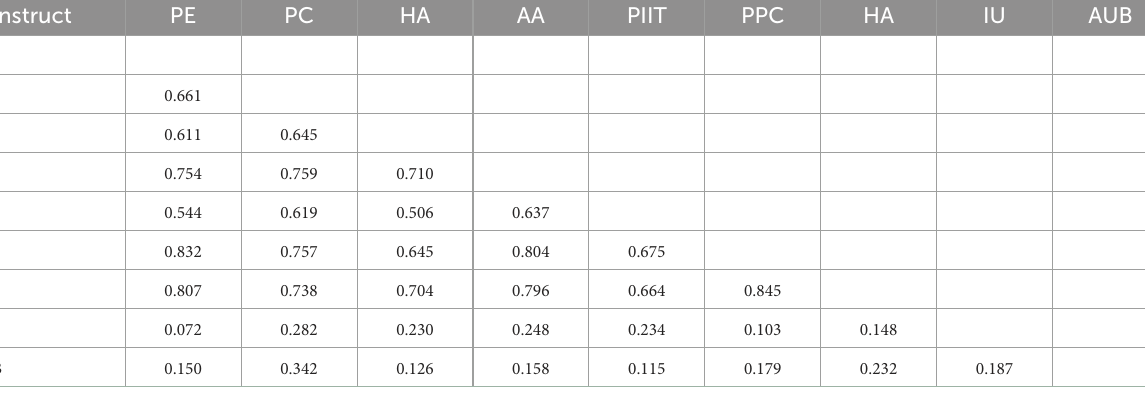
TABLE 5 Path analysis